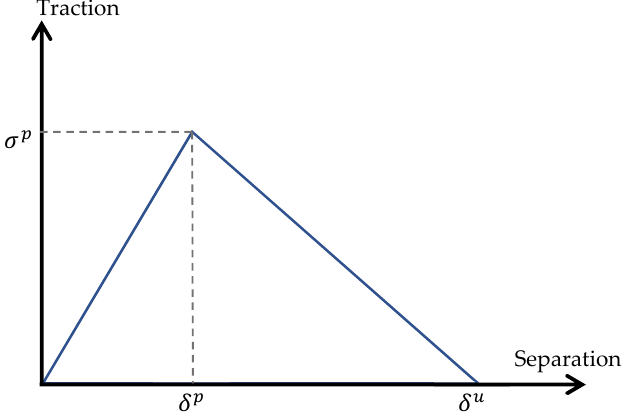
Figure 1. Boundary conditions and random mesh discretization of ( a ) plain and ( b ) center cracked laminates.